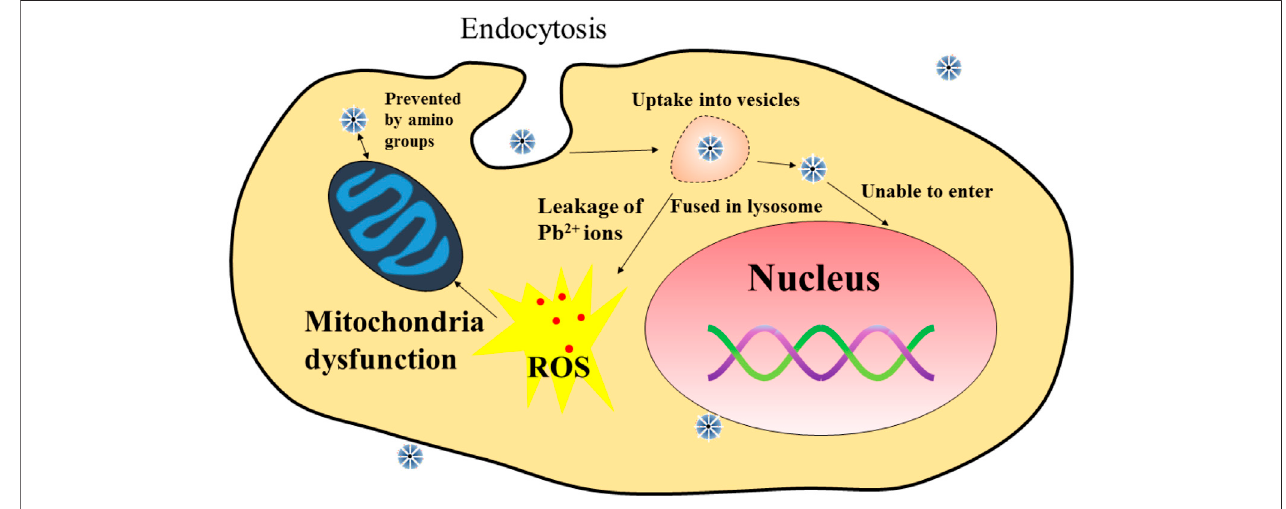
FIGURE 7 | Process of the Pb 2+ ions adsorbed on NPs inducing ROS in cells.